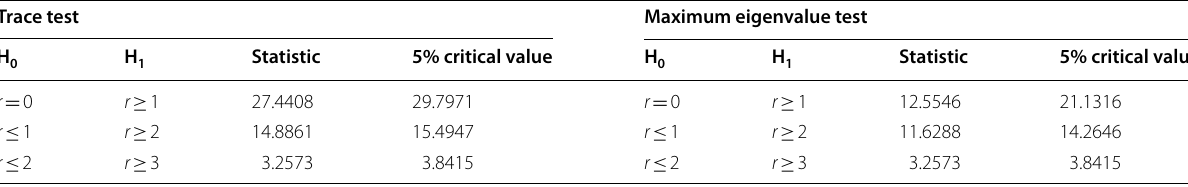
Trace test specifies no cointegration relationship (at p Max-eigenvalue test confirms no cointegration relationship (at p *Means rejection of the hypothesis (at p